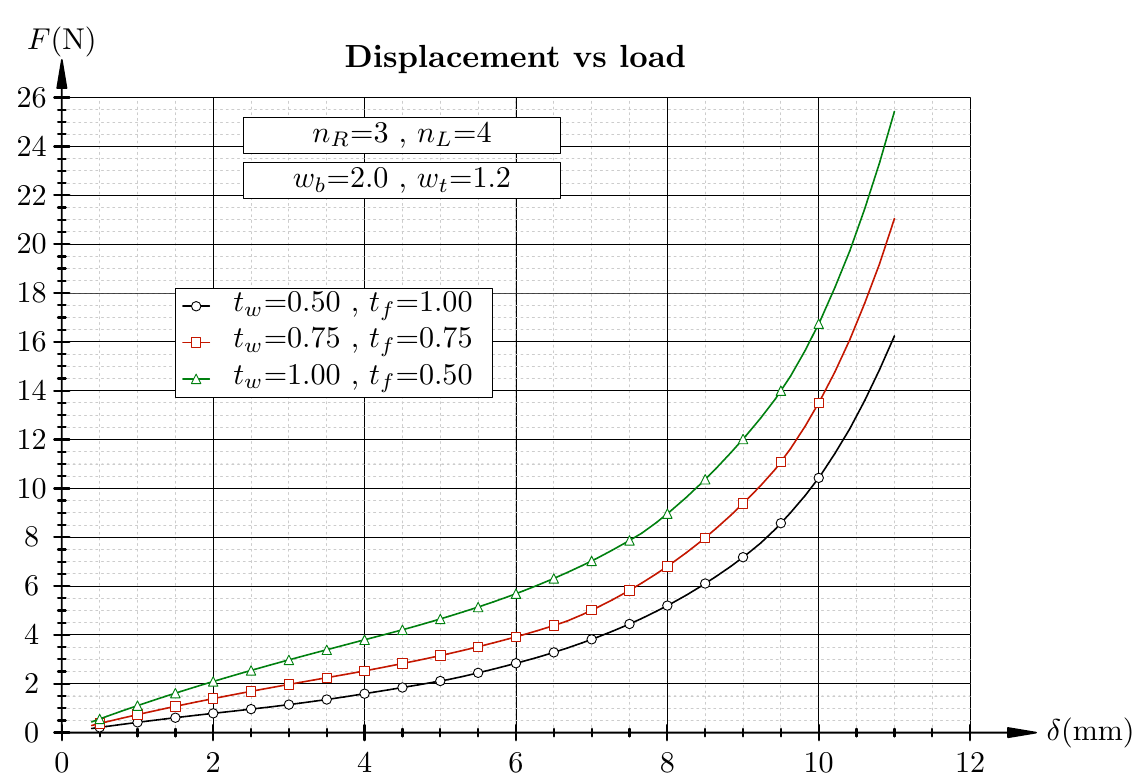
Figure 9. Variation of the circumferential and longitudinal cells number.